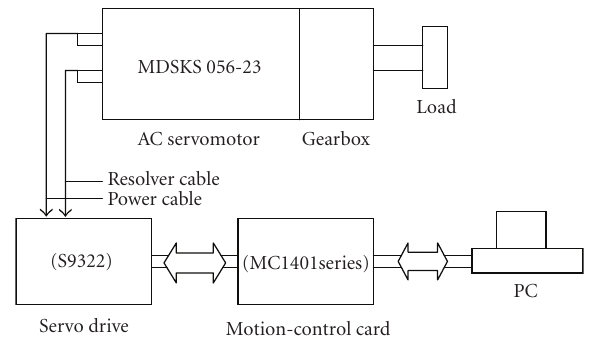
Figure 1: Configuration of system hardware.